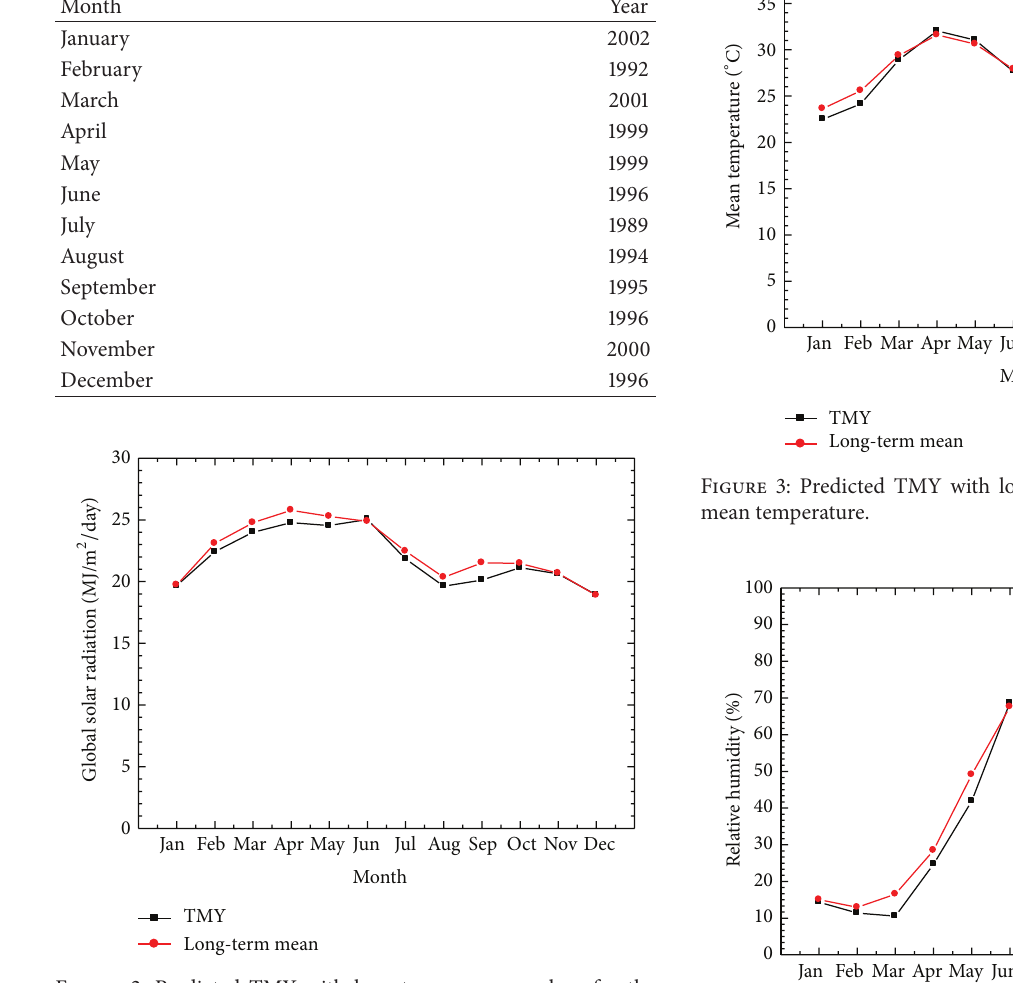
Figure 2: Predicted TMY with long-term average values for the global solar radiation.